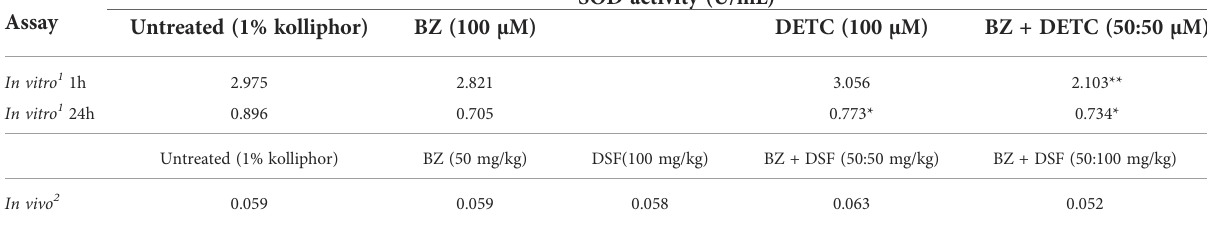
TABLE 2 Evaluation of T. cruzi superoxide dismutase (SOD) activity in presence of DETC in vitro and DSF in vivo isolated and combined to BZ. Assay